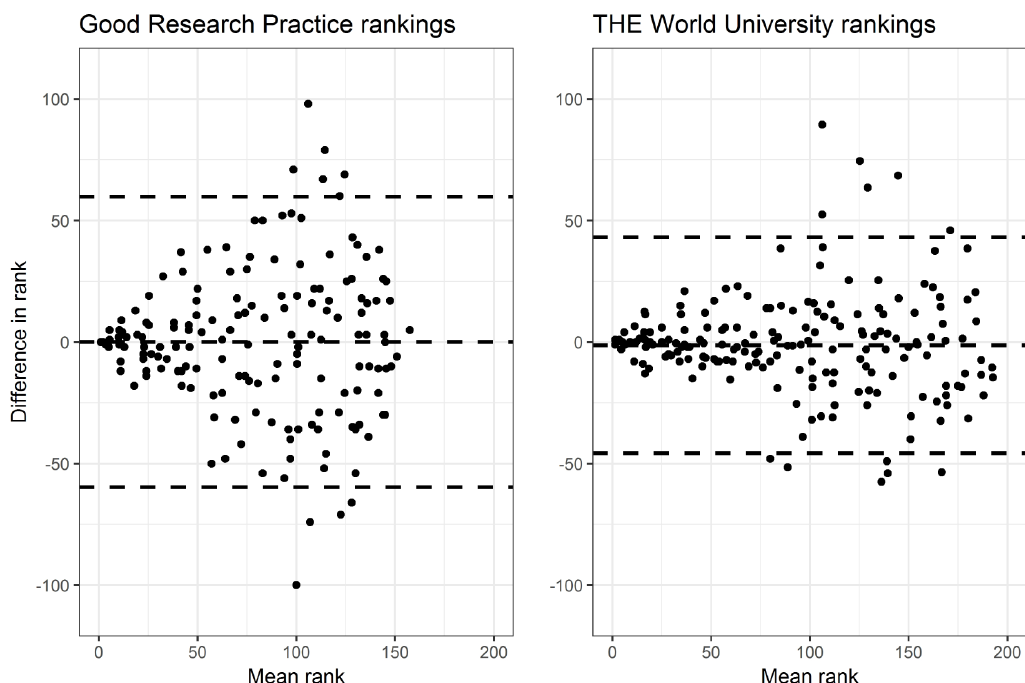
Figure 1. Bland–Altman plots of the agreement in university league table ranks between 2016 and 2017 for our good research practice league table and the Times Higher Education league table for research. We only examine universities in the top 200 in both years, which is 161 in our table and 184 in the THE table. The dashed horizontal lines are the Bland–Altman limits of